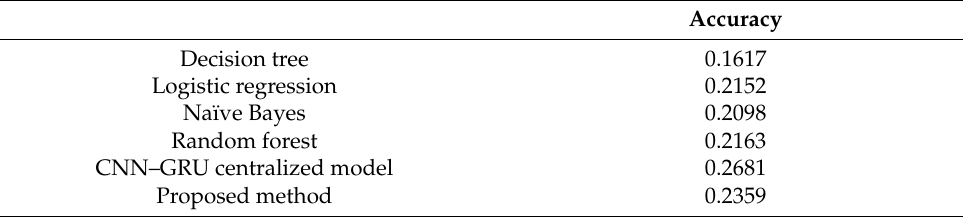
Table 6. Intrusion detection